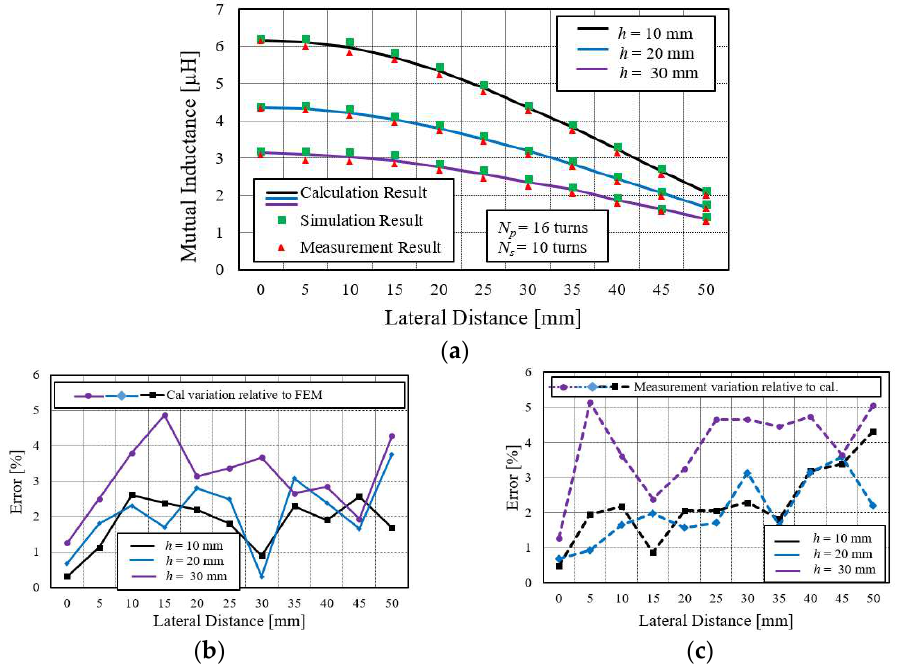
Figure 8. Mutual inductance comparison between large primary and small secondary coils at various lateral misalignment distances. ( a ) Primary large and secondary small coil. ( b ) Calculation variation relative to simulation (FEM) for N p = 16, N s = 10. ( c ) Measurement variation relative to